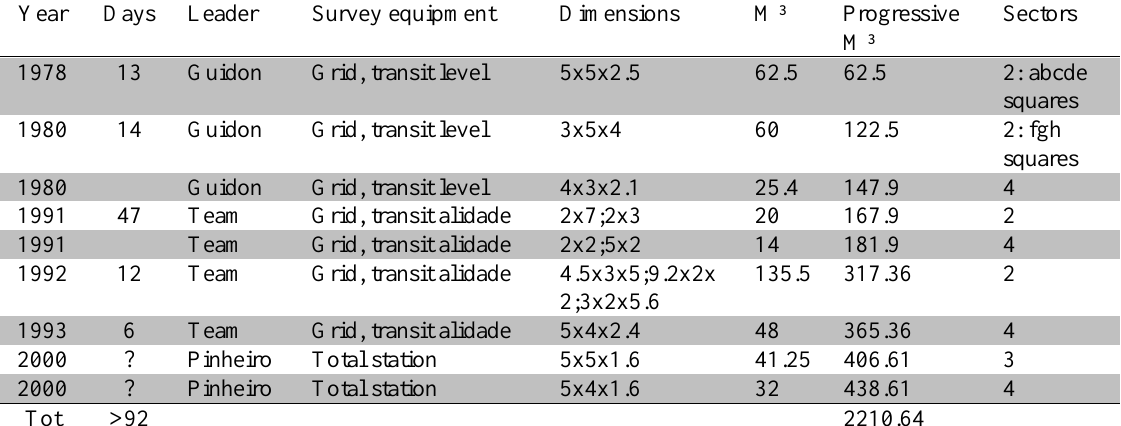
Table 1. Excavation campaigns at SDM: